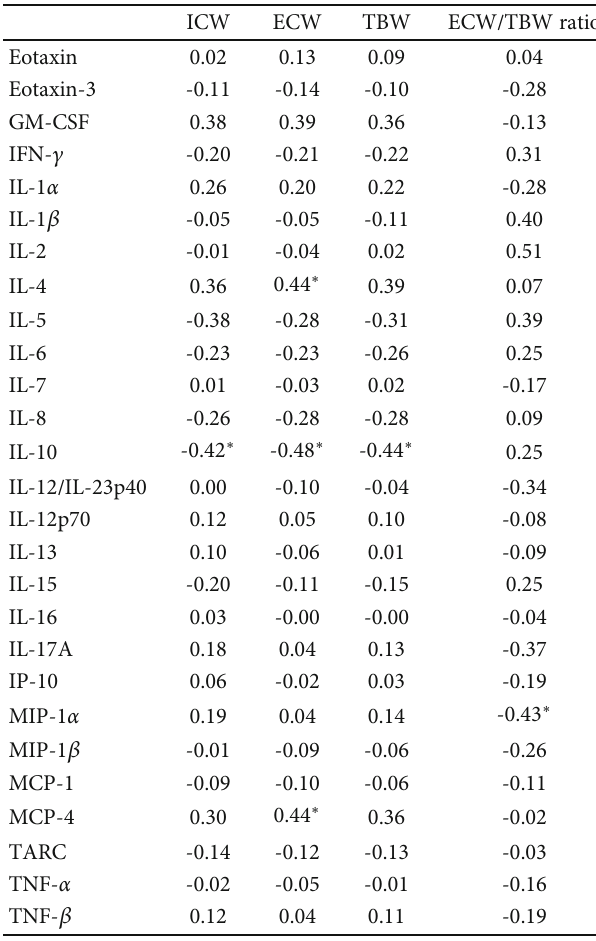
Table 4: Correlations ( r ) between cytokine concentrations and s water distribution variables in the AN sample